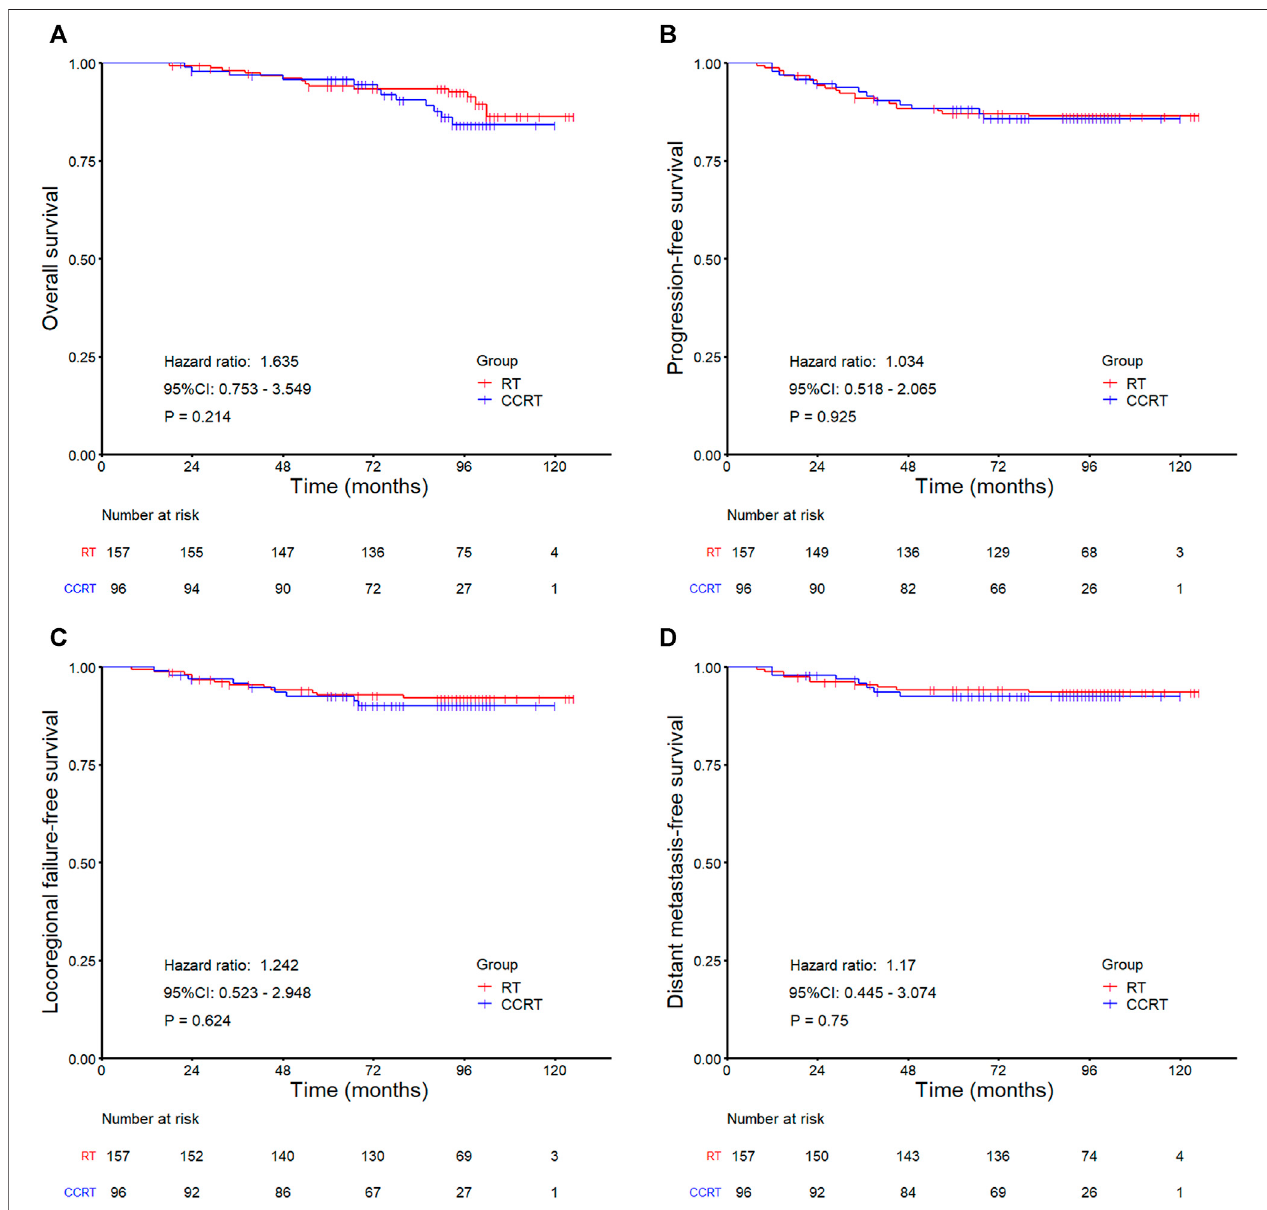
FIGURE 4 | Kaplan-Meier survival curves for the RT and CCRT groups in the IMRT subgroup analysis: (A) Overall survival, (B) Progression-free survival, (C) Locoregional failure-free survival, (D) Distant metastasis-free survival. Abbreviation: RT (cid:1) radiotherapy, CCRT (cid:1) concurrent chemoradiotherapy, IMRT (cid:1) intensity- modulated